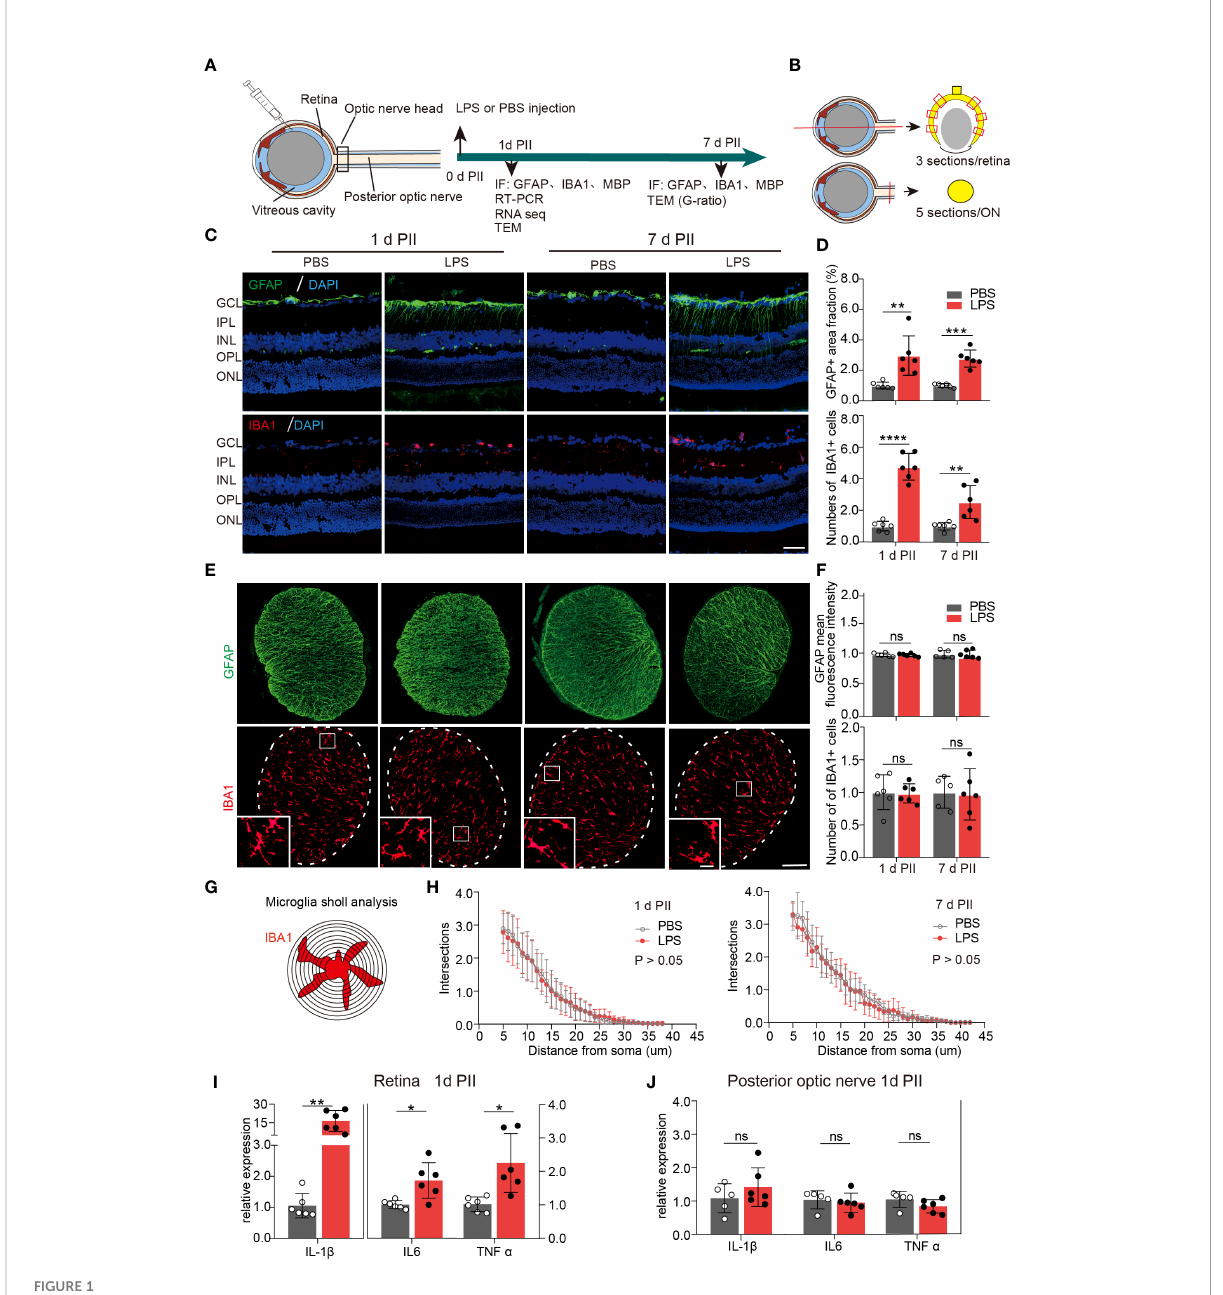
FIGURE 1 Intravitreal LPS injection induces obvious neuroin fl ammation in the retina but not in posterior ON. (A) Diagram of the experimental design. (B) Schematic illustration of the locations and orientations of extracting sections for immunostaining in the retina (upper panel) and posterior ON (lower panel). (C) Representative images of immuno fl uorescence staining of GFAP (green), IBA1 (red) and DAPI (blue) in the retina on day 1 and 7 post PBS or LPS intravitreal injection (1d PII or 7d PII). GCL, Ganglion cell layer; IPL, Inner plexiform layer; INL, Inner nuclear layer; OPL, Outer plexiform layer; ONL, Outer nuclear layer. Scale bar, 50 m m. (D) Histograms summarizing the fraction of the GFAP-positive staining area and the number of IBA1 positive cells in the immuno fl uorescence staining demonstrated in panel C; n = 6. (E) Representative images of immuno fl uorescence staining of GFAP (green) and IBA1 (red) in posterior ON on day 1 and 7 PII of PBS or LPS. Scale bar, 100 m m for coronal sections of the ON, 20 m m for inserts (lower panel). (F) Histograms summarizing the mean fl uorescence intensity of GFAP and the number of IBA1-positive cells in the immuno fl uorescence staining demonstrated in panel E; n = 5-6. (G) Schematic illustration of microglia Sholl analysis in the coronal sections of the posterior ON; (H) Sholl plot demonstrating the number of intersections between the microglia branches and each increasing concentric circle plotted against the distance away from the soma ( m m) based on IBA1 staining in the ON on day 1 (left panel) or day 7 (right panel) PII of PBS or LPS demonstrated in panel E; n =6. (I, J) mRNA expression levels of IL-1 b , IL-6, and TNF- a in the retina and ON on day 1 PII. The expression levels of the LPS group were normalized to those of the PBS group; n = 5-6 per group. All data are presented as the mean ± SD. Unpaired t-test or Mann-Whitney test was performed for statistical analysis or two-way repeated measures ANOVA was performed for statistical analysis; n.s., P > 0.05, *P < 0.05, **P < 0.01, ***P < 0.001, ****P < 0.0001., ns, non-signi fi